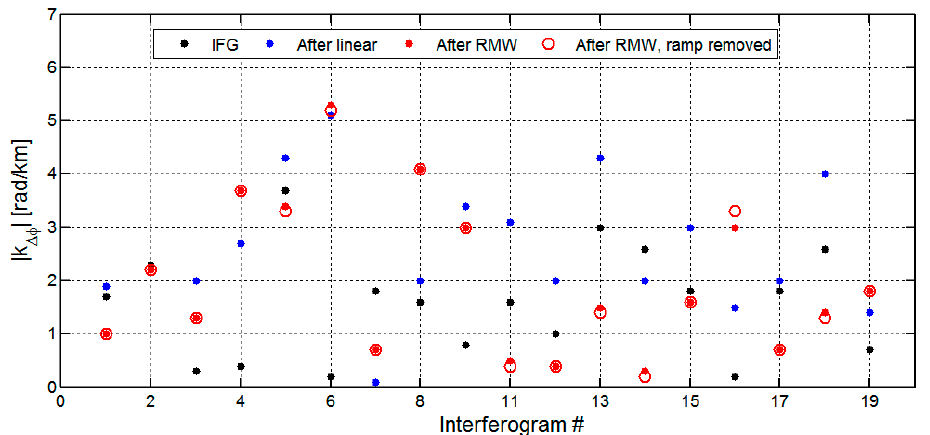
ˇ ˇ ˇ ˇ for full interferograms after correction ˇ k ∆ ˇ for full interferograms after correction with  φ